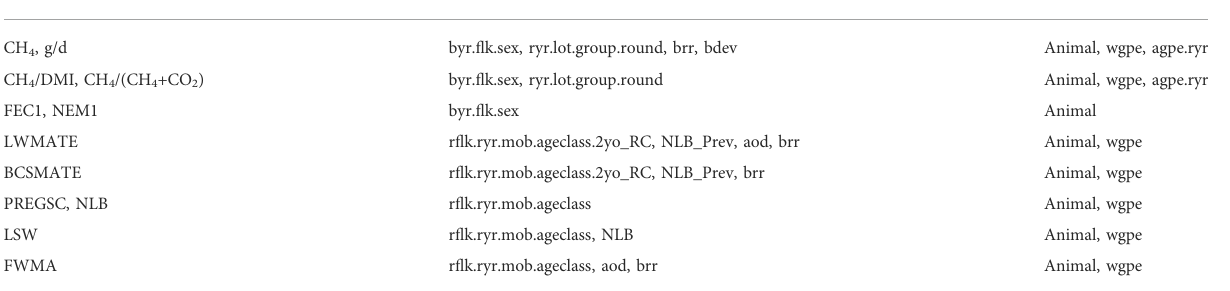
TABLE 2 Effects in the fi nal model for each